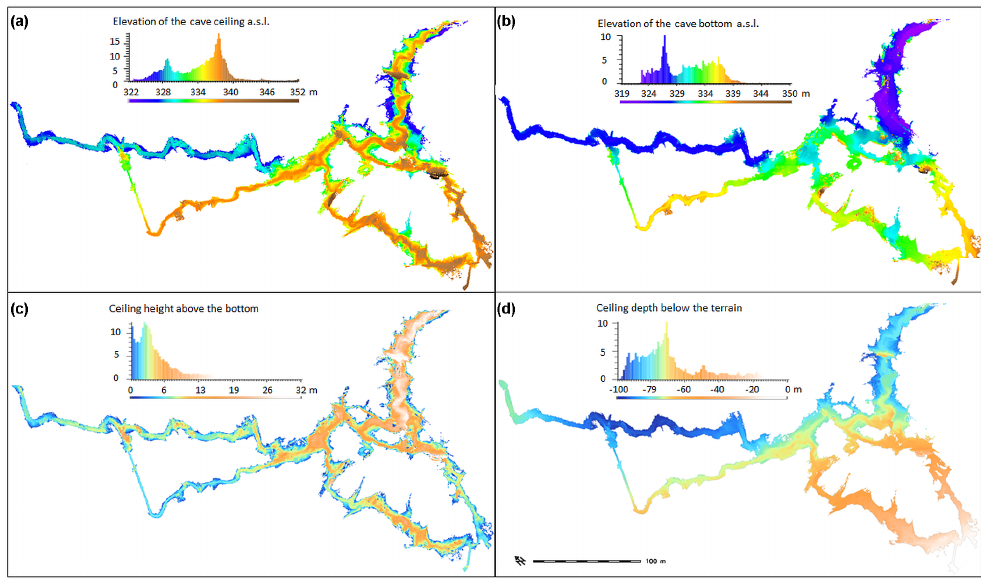
Figure 6. Raster based models with histograms representing the highest cave ceiling altitude (a) , lowest altitude (b) , vertical difference between the cave bottom and ceiling (c) , and the ceiling depth below the terrain surface (d) . The histogram y axis represents the number of raster cells in hundreds. Table 5. Summary of elevation and length statistics of the ceiling line segments as shown in Fig. 8. Cave